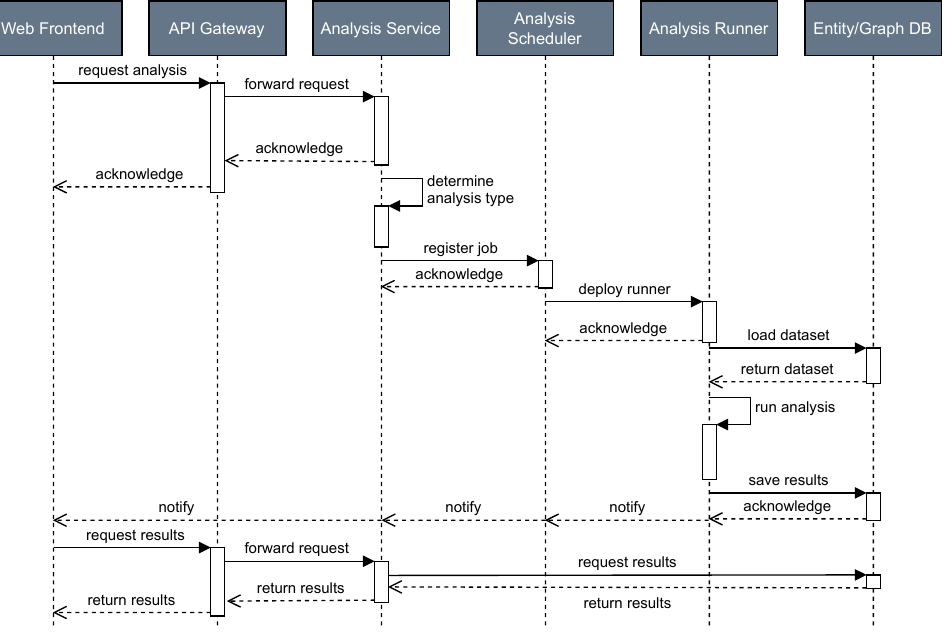
Figure 11. UML sequence diagram for “bibliometric networks computation”.